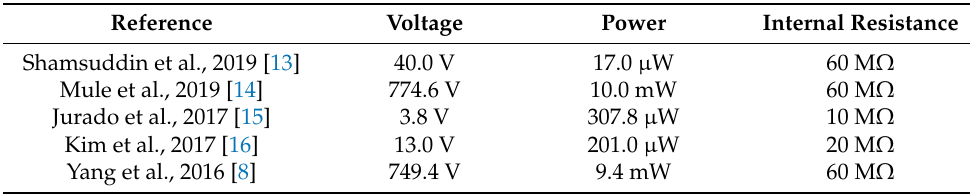
Table 1. Internal resistance of several existing triboelectric energy harvesters.